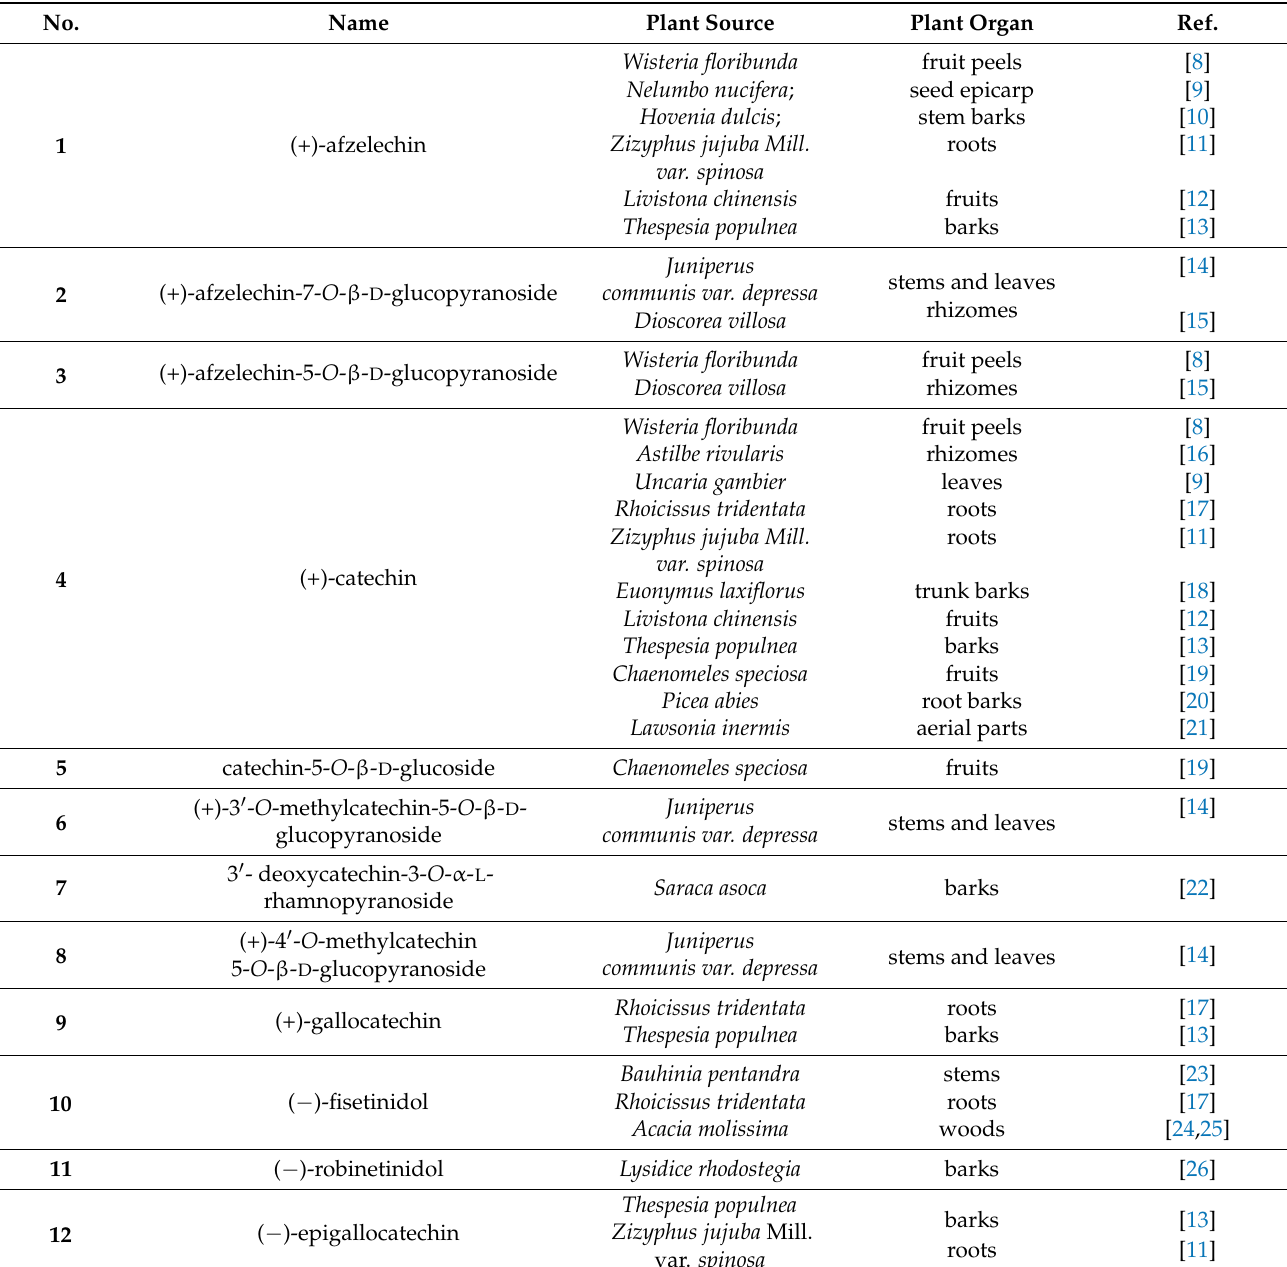
Table 1. The numbers, plant sources, corresponding organs of